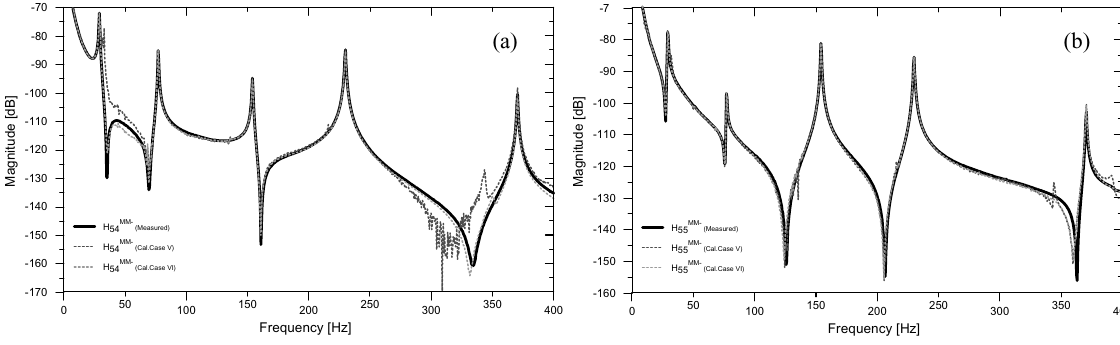
Fig. 20. Measured and estimated Receptance (a) H (cid:2) 54 for cases V and VII and (b) H (cid:2) 55 . for cases V and VI, for the MM-